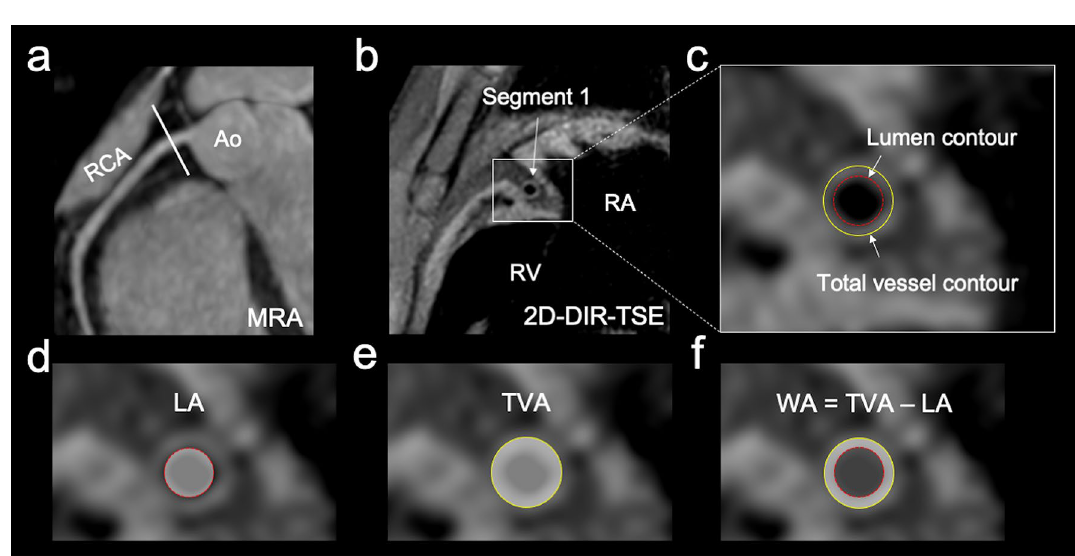
Figure 4. Regions of interest segmentation. The MRA-collapsed partial MIP image demonstrates RCA segments 1 in a 19-year-old boy (case 8) ( a ). At 6 months of age, he experienced a coronary artery aneurysm of up to 5.9 mm in RCA segments 1. It is currently involuted and divided into normal regions. The white line depicts the slice position in the two-dimensional dual inversion-recovery turbo spin-echo (2D-DIR-TSE) cross-sectional image ( b ). Image ( c ) is an enlarged image of the measurement location of ( b ). The lumen of the coronary artery (red dotted line) and the boundaries of the wall (solid yellow line) have been manually contoured ( c ). Subsequently, the lumen area (LA), the total vessel area (TVA), and the wall area (WA) have been measured ( d–f ) ( Ao aorta, RA right atrium, RV right